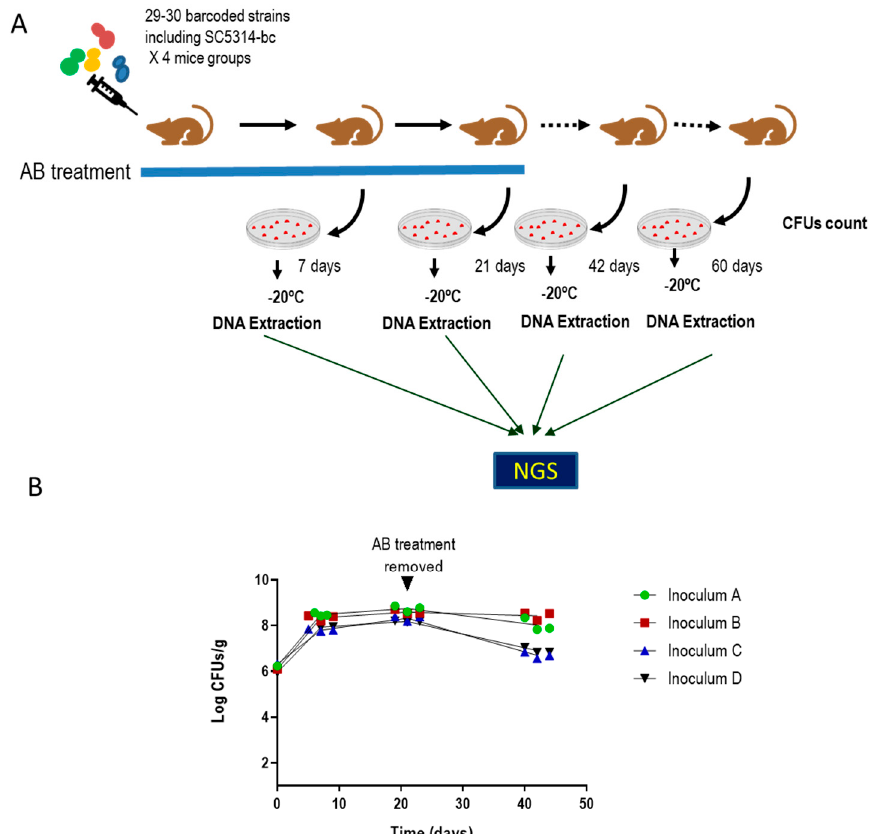
Figure 1. Assay to identify C. albicans clinical isolates with increased ability to colonize the murine gut. ( A ) Schematic representation of the assay. ( B ) Fungal colonization load of C. albicans strains in pool. Inoculum A, B, C and D correspond to the four pools of C. albicans barcoded strains (supplementary file S1). Each C. albicans strains pool was inoculated intragastrically in 3 mice with a partially depleted microbiota. Antibiotic treatment was maintained for 21 days after C. albicans gavage then, it was removed. Stools were taken at different time points and processed for CFUs counting. Data are represented and expressed as log CFUs per stool gram versus time (days). Each replicate is shown and each line represents the mean of the data.